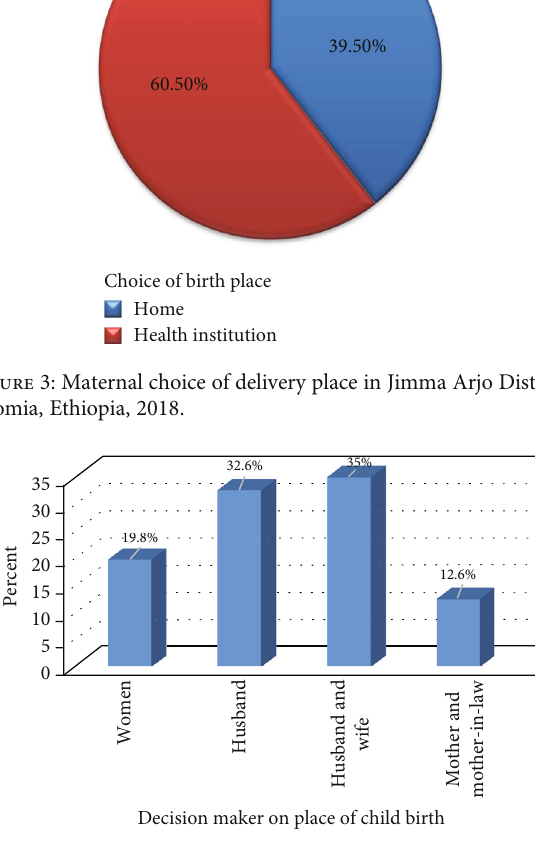
Figure 4: Woman decision making powering Jimma Arjo District, Oromia, Ethiopia, 2018.